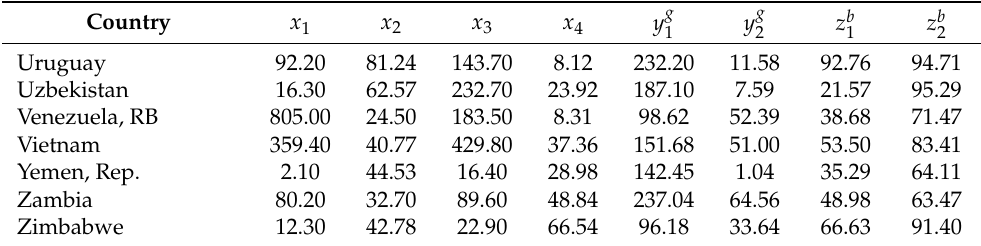
Table A2. Trade-off effects on the methane ( z b